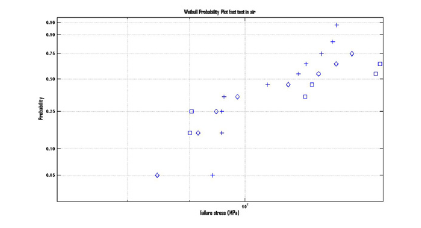
Figure 4: Weibull plot of all fast air tests in a single series.